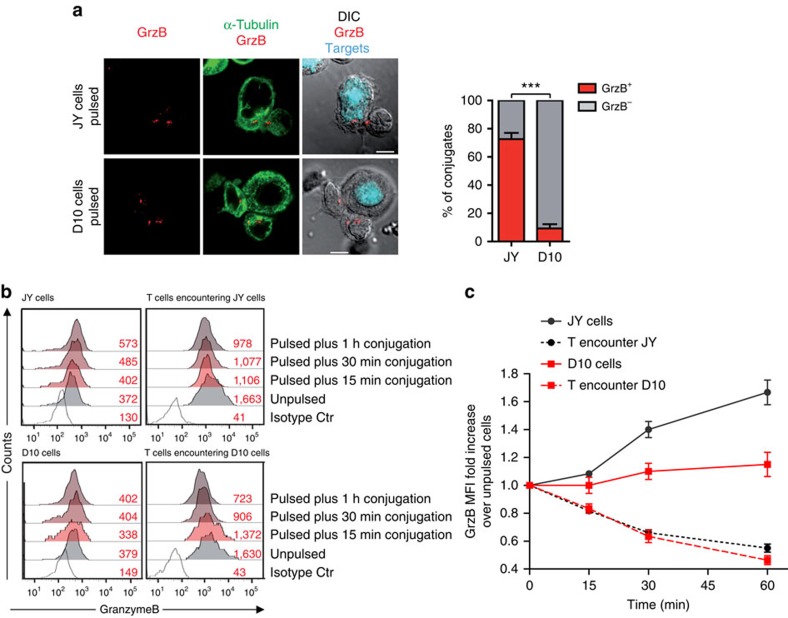
Defective granzyme B penetration in melanoma cells.(a) Visualization of GrzB staining in CTL/target cell conjugates by confocal laser scanning microscopy. Target cells were previously pulsed with 10 μM peptide. Cells were stained with anti-α tubulin (green) and anti GrzB (red). Target cells were identified by loading them with Cell Tracker Blue before conjugation (cyan). Percentage of GrzB+ target cells in peptide-pulsed JY and D10 cells are indicated. Sixty conjugates from three independent experiments were scored. Scale bars, 5 μm. Results are expressed as mean±s.e.m. of three independent experiments. Unpaired Student's t-test using the GraphPad Prism software was used to determine the statistical significance of differences between the groups. ***P<0.001. (b) Left panels: time kinetics of GrzB staining in conventional target cells (JY) and melanoma cells (D10), either unpulsed or pulsed with 10 μM peptide concentration, following conjugation with CTL. Right panels: time course of GrzB loss in CTL following interaction with target cells. Target cells were either unpulsed or pulsed with the antigenic peptide. The median fluorescence intensity of GrzB staining is indicated. Results are from one representative experiment out of three. (c) Pooled results from three independent experiments showing the time-dependent loss of GrzB by CTL interacting with JY cells (black dotted lines) or with D10 cells (red dotted lines) and GrzB uptake by JY cells (black plain lines) or by D10 cells (red plain lines). MFI, median fluorescence intensity. Results are expressed as mean±s.e.m. of three independent experiments.